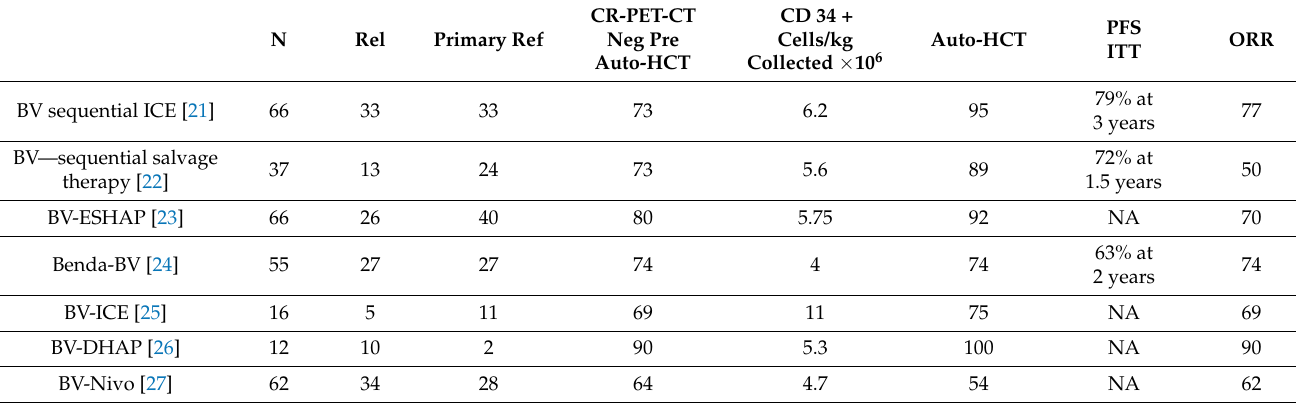
Table 3. Salvage regiments before auto-SCT—new drugs with chemotherapy-combination